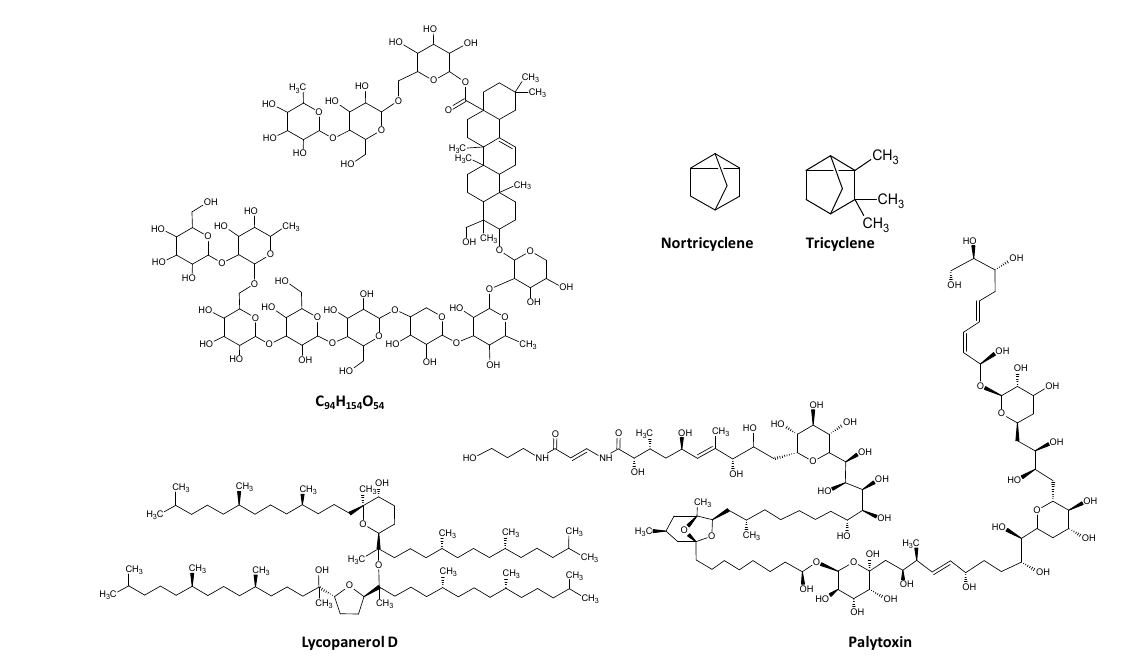
Figure 4. Structure of the terpenes that occupy the lower and upper range of the MW and logP in the Figure 4 - Structure of the terpenes that occupy the lower and upper range of the MW and logP in the terpene family. Nortricyclene is the smallest molecule in the database (94.15 Da), while palytoxin terpene family. Nortricyclene is the smallest molecule in the database (94.15 Da), while palytoxin is is the one with higher MW (2680.14 Da). The unnamed molecule (no common name) is the entry the one with higher MW (2680.14 Da). The unnamed molecule (no common name) is the entry with with the lowest logP (−10.4), while lycopanerol D presents the highest calculated logP (50.2). the lowest logP ( − 10.4), while lycopanerol D presents the highest calculated logP (50.2). The distribution of MW across all terpenes is presented in Figure 1. From a phytochem- ical point of view, the different terpene subclasses are grouped based on their biosynthesis and, consequently, the number of isoprene units in their structure. For this reason, it is ob- Figure 4 - Structure of the terpenes that occupy the lower and upper range of the MW and logP in vious that marked differences in molecular weight can be found across distinct subclasses. the terpene family. Nortricyclene is the smallest molecule in the database (94.15 Da), while palytoxin is the one with higher MW (2680.14 Da). The unnamed molecule (no common name) is the entry with the lowest logP (−10.4), while lycopanerol D presents the highest calculated logP (50.2). shows the molecular weight distribution as a function of the subclass.